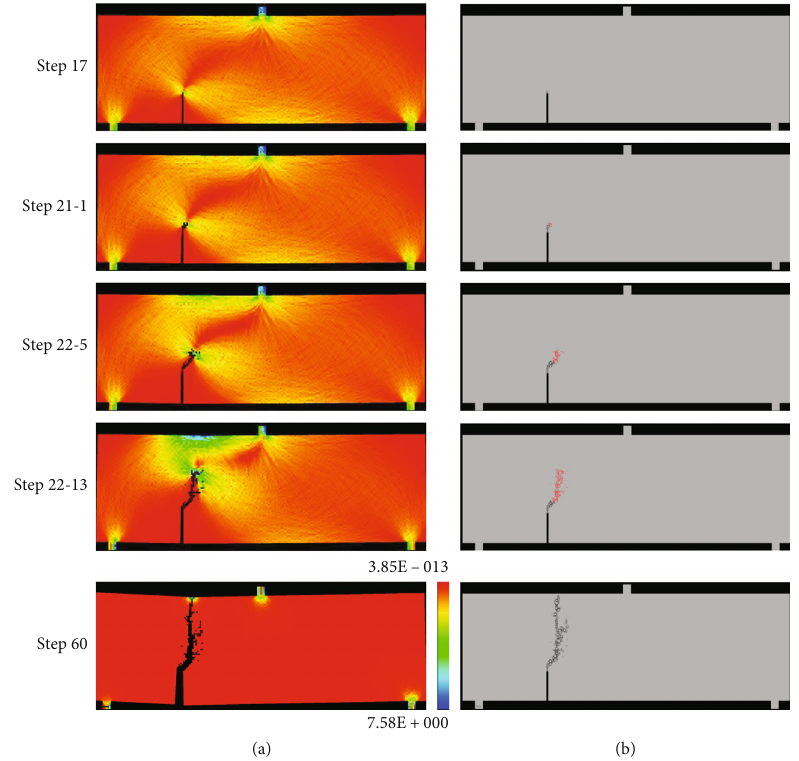
Figure 4: The failure process of a = 50 mm beam: (a) the stress cloud diagram; (b) the acoustic emission diagram.